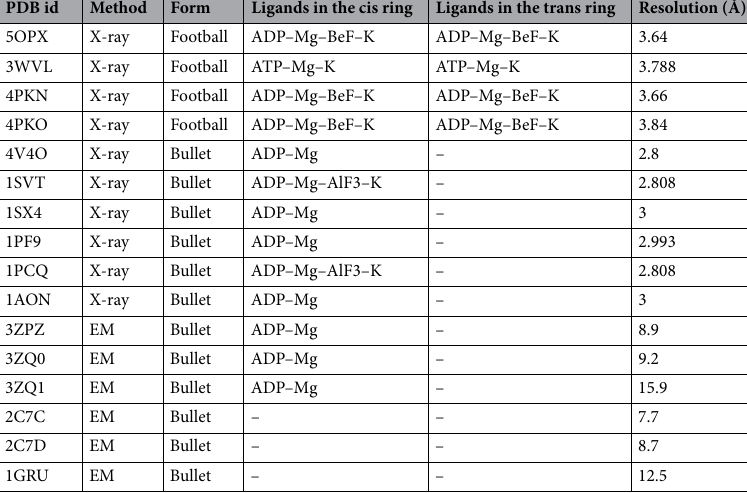
Table 1. Structures of the GroEL–GroES complex deposited in the Protein Data